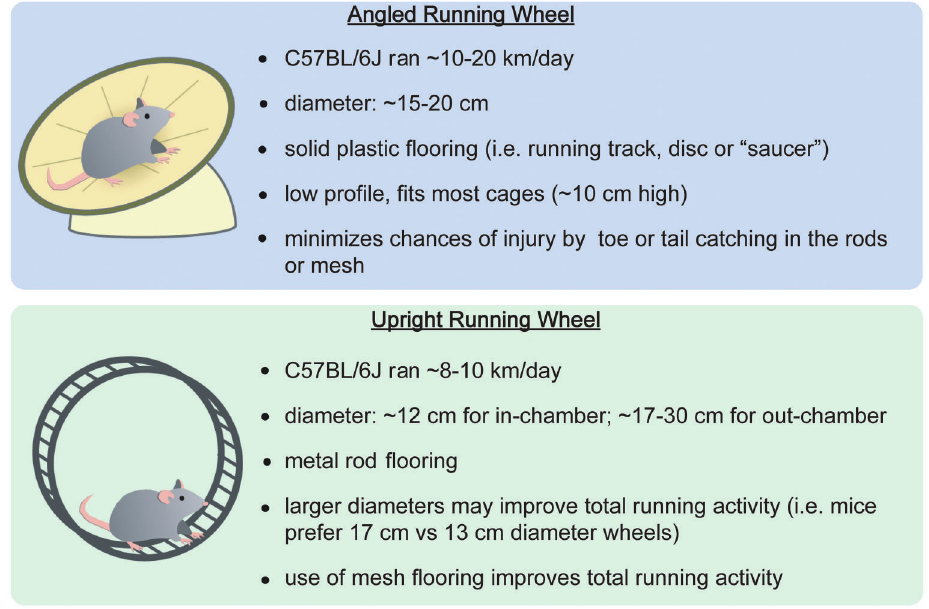
Figure 1. Characteristics of the different types of running wheels for mice. The design of the running wheel can affect total voluntary running activity in mice. Mice present higher voluntary running activity in angled wheels compared to upright wheels.